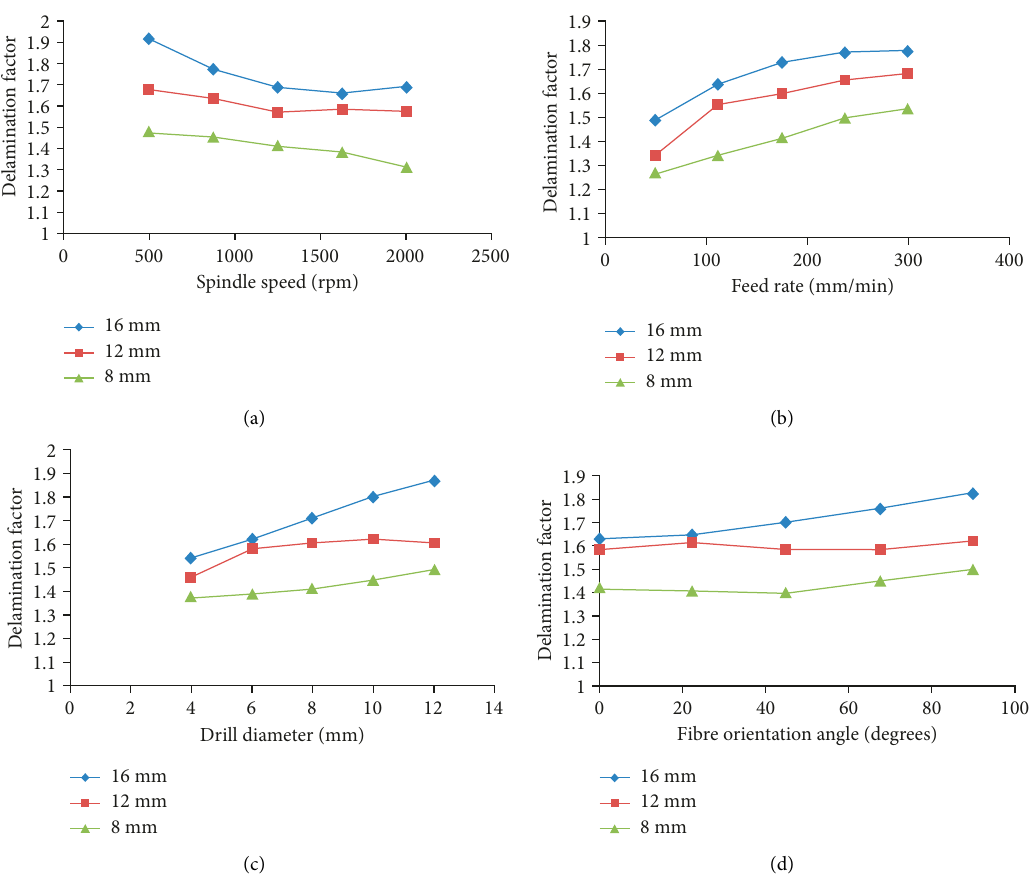
Figure 3: Effect of various input parameters on delamination factor (a) spindle speed, (b) tool feed rate, (c) drill diameter, (d) and fiber orientation angle.